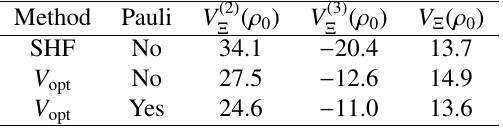
Table 3. Ξ -nuclear potential depths (in MeV) from a large-scale SHF fit [30] and from our V opt